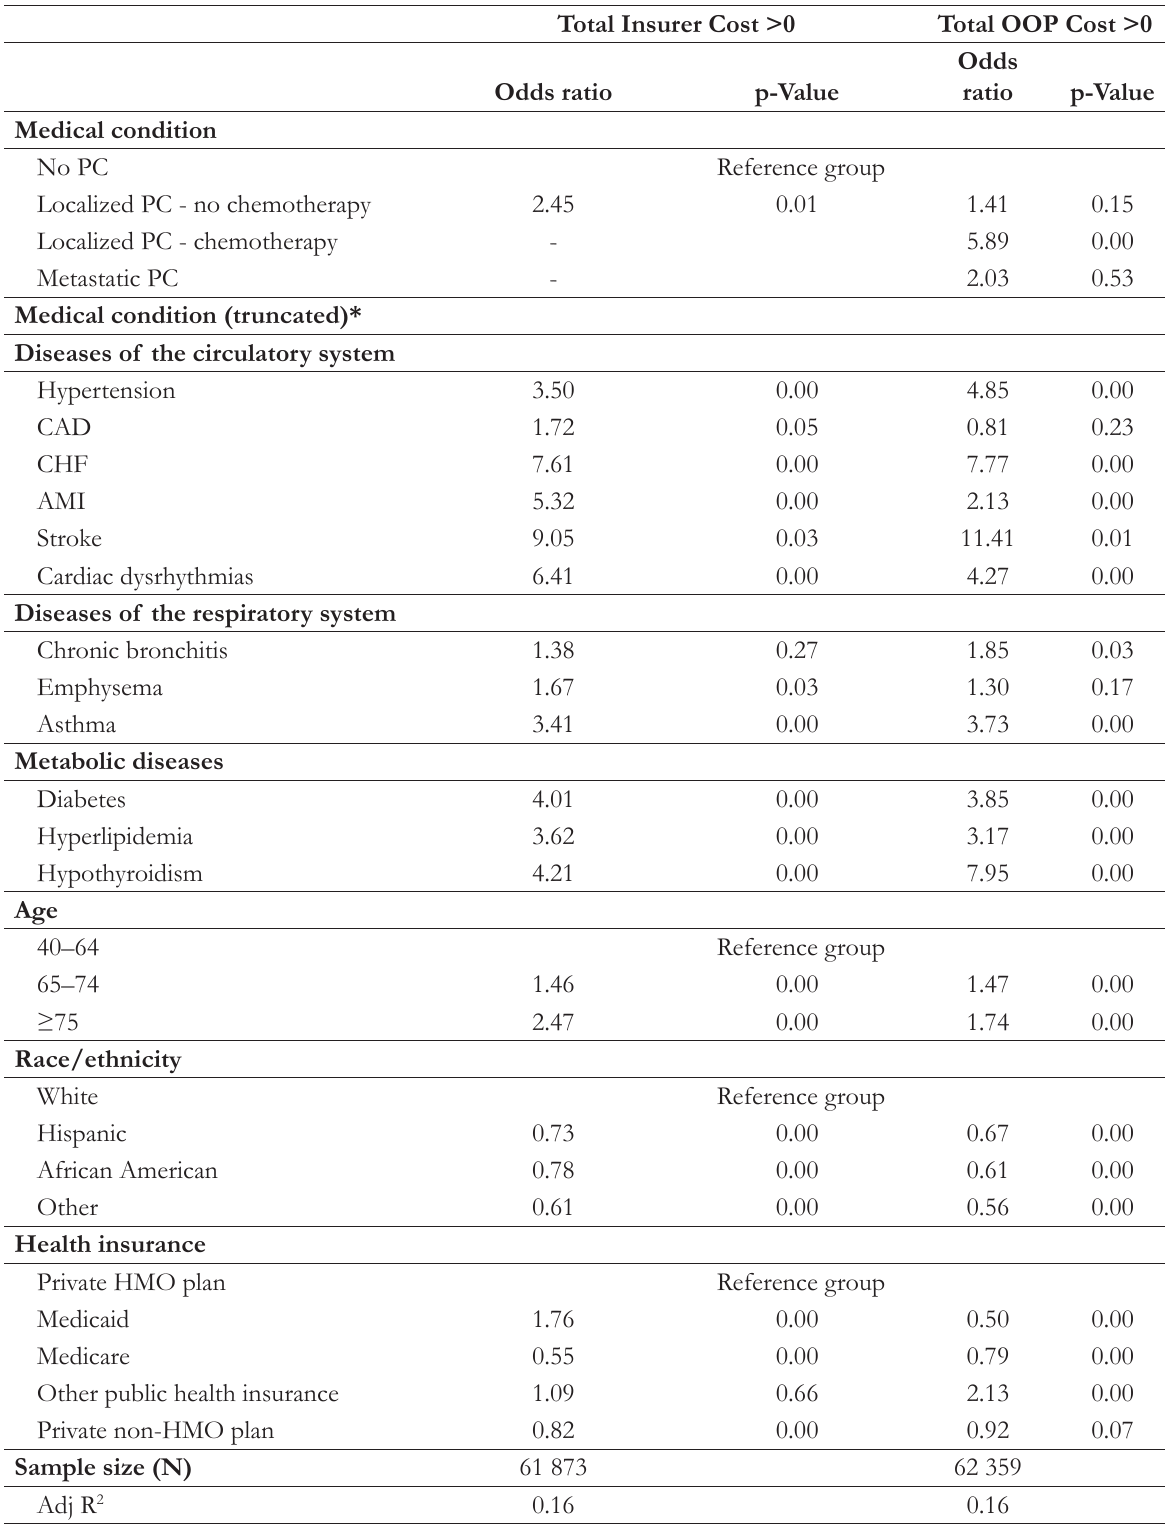
Table 2. Logistic Regression of the Probabilities of Positive Insurer Expenditure and Positive OOP Expenditures [per